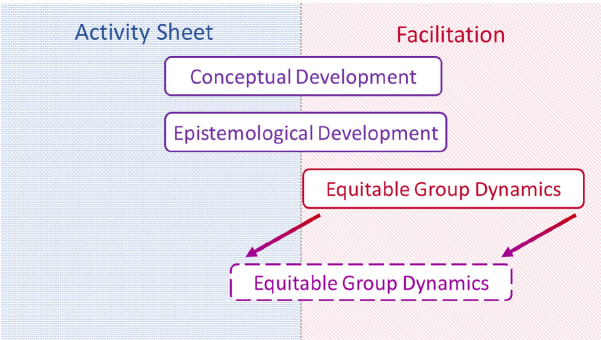
FIG. 1. Division of labor between activity sheet developers and classroom facilitators. We argue that developers should take on a greater share of responsibility for fostering equitable team